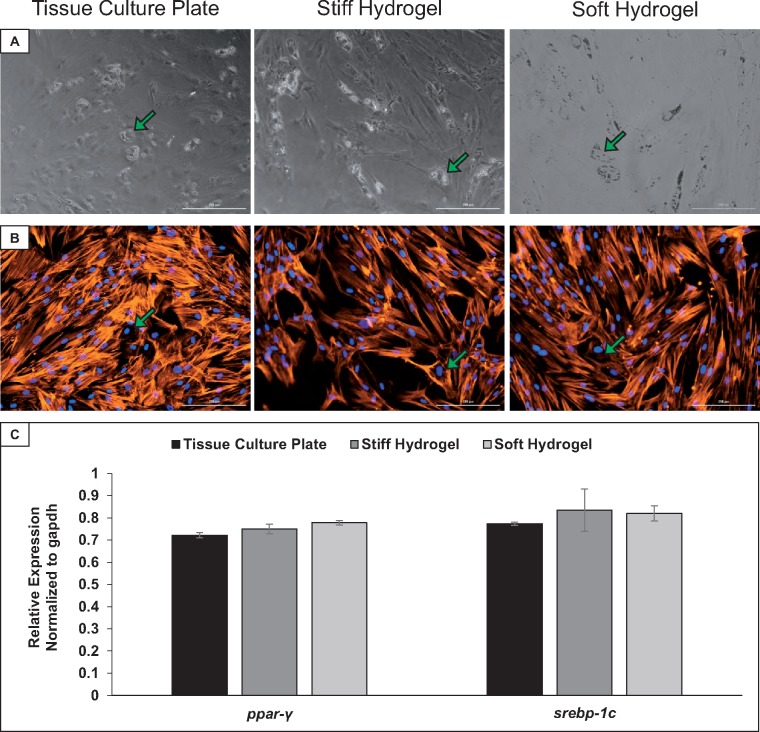
hMSCs retain the ability to differentiate toward adipogenic lineages on all three elasticity conditions. (A) Phase contrast images of hMSCs at day 7 of adipogenic differentiation. (B) Morphology of hMSCs at day 7 of adipogenic differentiation, corresponding to the phase contrast images in panel A. The cell nuclei are shown in blue, while the F-actin filaments are shown in orange. Cells containing lipid vesicles demonstrated a rearrangement of F-actin filaments, indicated by green arrows. (C) quantitative reverse-transcriptase PCR analysis of the adipogenic differentiation markers ppar-γ and srebp1-c in hMSCs at day 7 of adipogenic differentiation. Results considered insignificant with P > 0.05. n = 3. Scalebars: 200 µm